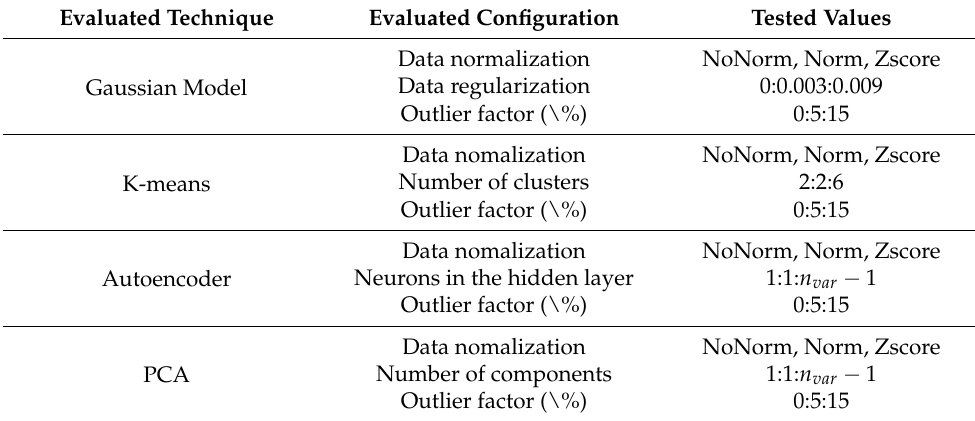
Table 1. Configurations